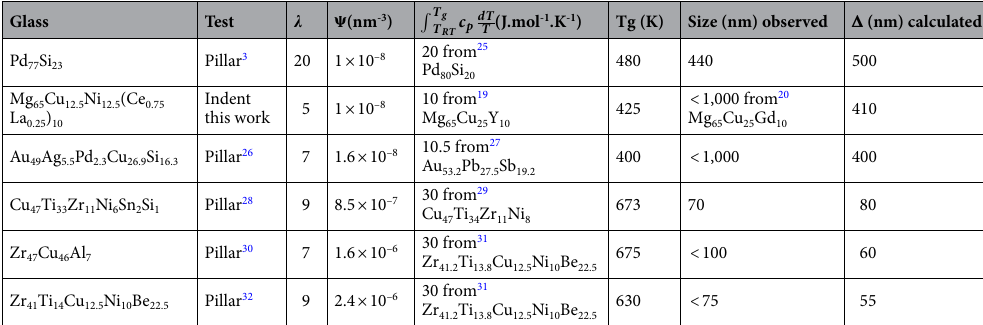
Table 1. Comparison between observed and calculated critical size (cid:31) for various metallic glass alloys. Structural parameters, glass transition temperature and entropy are